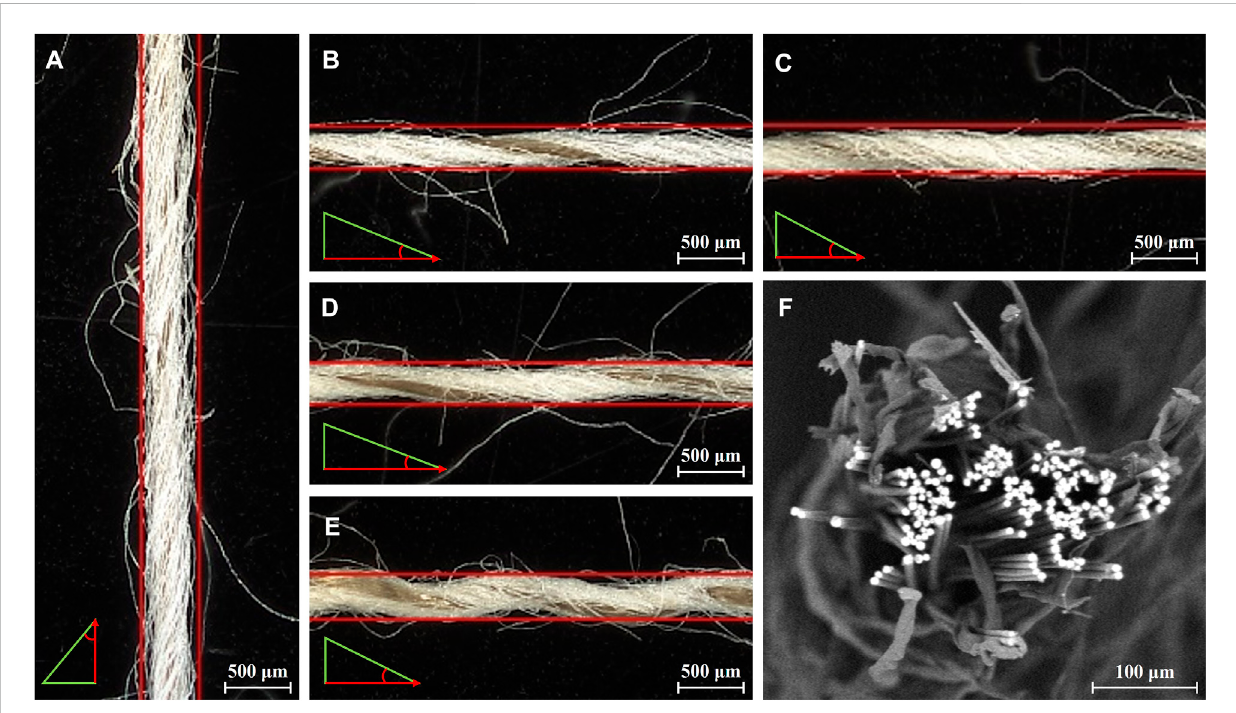
FIGURE 6 Appearance comparison of yarns spun by different twists: (A) A f ; (B) A g ; (C) A h ; (D) A j ; (E) A k and (F) an optical micrograph of cross-section morphology of low-torque composite